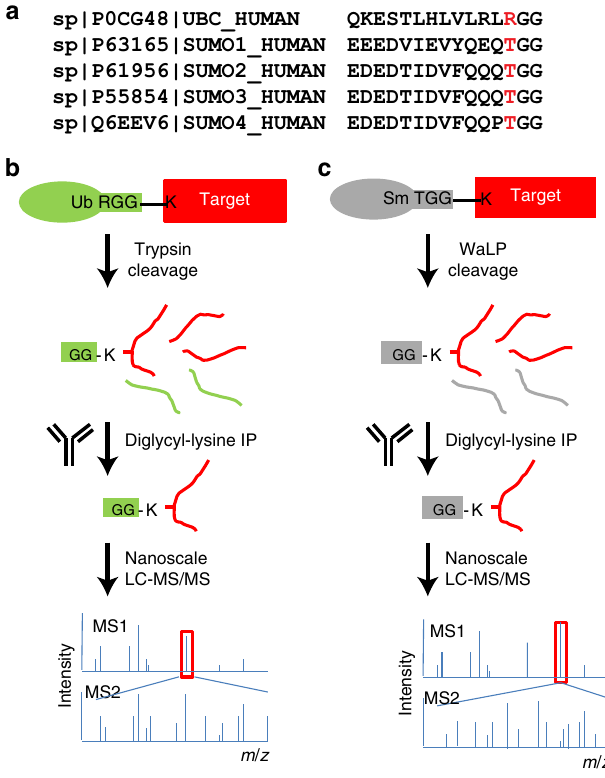
Fig. 1 A strategy for mapping endogenous SUMO-modi fi cation sites. a C-terminal sequence alignment of processed human SUMO1-4 and ubiquitin. The proximal amino acid to the diGlycine C-terminal residues is indicated in red. b Schematic depicting the Ub site mapping